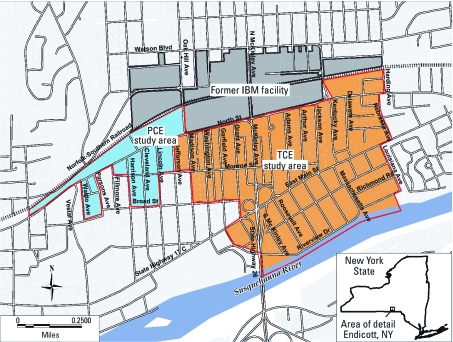
The TCE and PCE study areas and the location of the former IBM manufacturing facility, Village of Endicott, New York (USA).